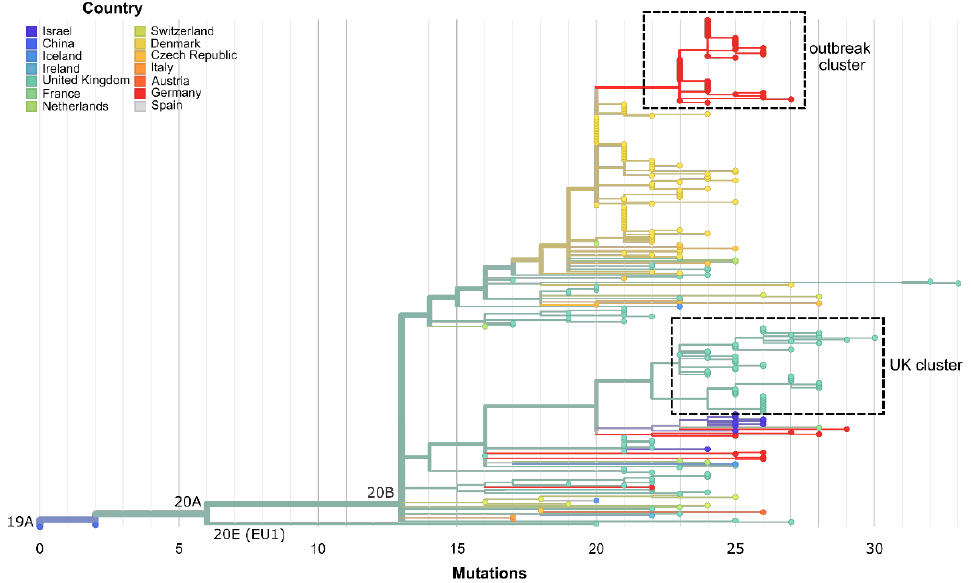
Figure 3. Maximum-likelihood phylogenetic tree from Nextstrain comprising 307 SARS-CoV-2 genome sequences [22,30]. Branch lengths are determined by genetic divergence. The dataset consists of nine genomes from GISAID with the ∆168 ORF8 deletion, 239 genomes with a similar SNV signature, 13 genomes with the ∆168 ORF8 deletion masked by a stretch of Ns, 44 genomes from this study stemming from the hospital outbreak and two Wuhan reference sequences (WH01, Hu-1). The hospital outbreak cluster is visible at the top (red) and is directly preceded by sequences from Denmark (yellow), which have similar SNV signatures but no large deletion in ORF8. A distinct cluster of sequences from the UK (turquoise) also shows the deletion in the raw sequence data, whereas the consensus sequences contain variable stretches of ambiguous bases. Seven sequences listed in Table S2 have been removed due to missing metadata by the Nextstrain tree